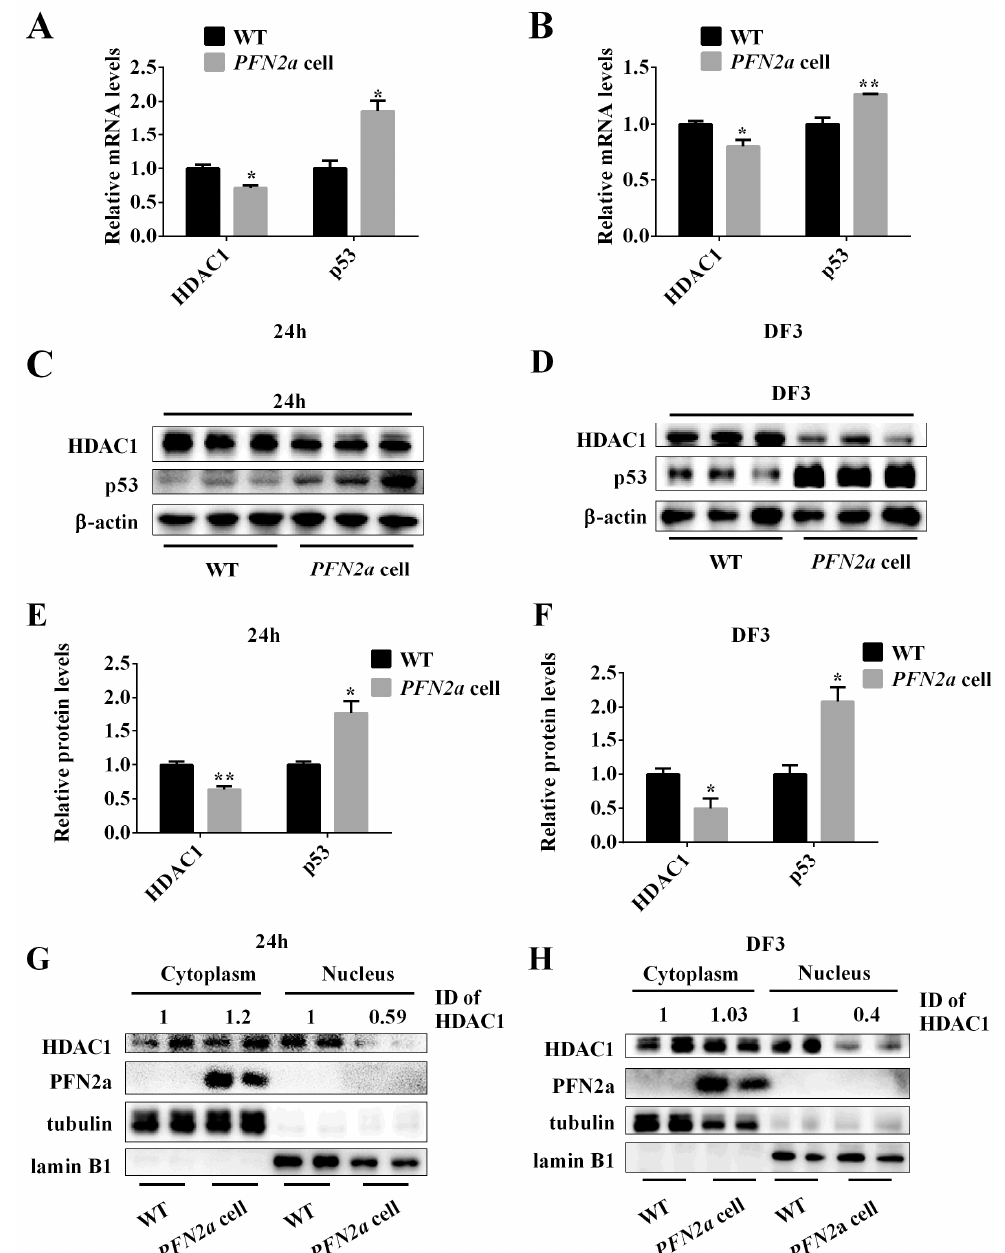
Figure 5. PFN2a overexpression downregulated the content of HDAC1 in the nucleus, but upregulated the level of p53 during the C2C12 myogenic development. ( A , B ) PFN2a downregulated the mRNA level of HDAC1 and upregulated mRNA level of p53 on proliferation day 1 and di ff erentiation day 3. ( C , D ) Western blot results showed that the protein level corresponded to the mRNA result. ( E , F ) The relative protein level of HDAC1 and p53 obtained through WB band gray scanning analysis on proliferation day 1 and di ff erentiation day 3. ( G , H ) PFN2a reduced the nuclear content of HDAC1 on proliferation day 1 and di ff erentiation day 3. Lamin B1 and tubulin were used as nuclear- or cytoplasmic-specific protein loading controls, respectively. The results are presented as mean ± S.E.M. of triplicate experiments for each group, and statistical significance of di ff erences between means was assessed using unpaired Student’s t -test (*, p < 0.05; **, p < 0.01). Band intensities were quantified by Image J software and normalized to tubulin or lamin B1. Data were expressed as change in fold relative to the control. WT: wild type C2C12 cells; PFN2a cell: PFN2a -overexpressing C2C12 cells. 24h: on proliferation day 1. DF: di ff erentiation. ID: integrated